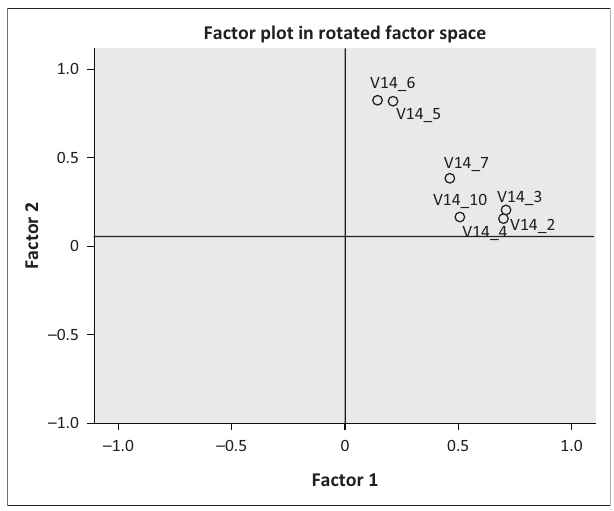
FIGURE 3: A factor plot in rotated space of the two first-order factors involved in learner TABLE 9: Significance of differences between the two management or leadership groups with respect to the two first-order factors. Factor Group Mean t -test The school’s motivation in learner performance in the Foundation Phase (F1.1)